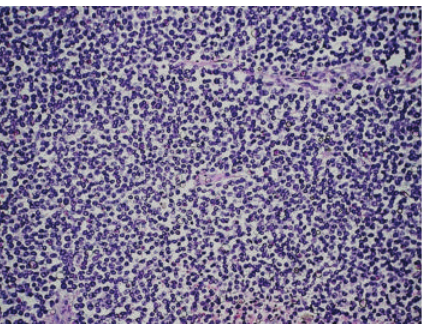
Figure 2: PNET arising in the liver: di ff use sheet of uniform small round cells in a lobulated growth pattern, HE, 200x.